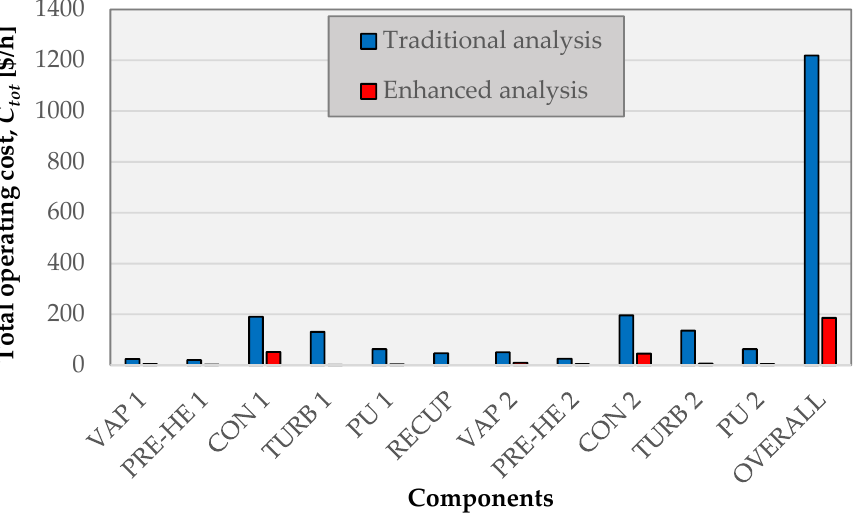
Figure 2. Change in total operating cost for the components for both analyses.